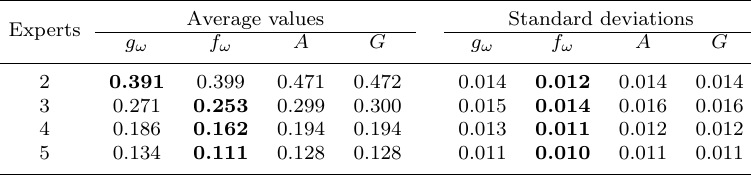
Table 8. Average values and standard deviations of error probabilities in ranking alterna- tives for different aggregation functions. Matrix ˜ P 1 (“average” experts). Average values Experts